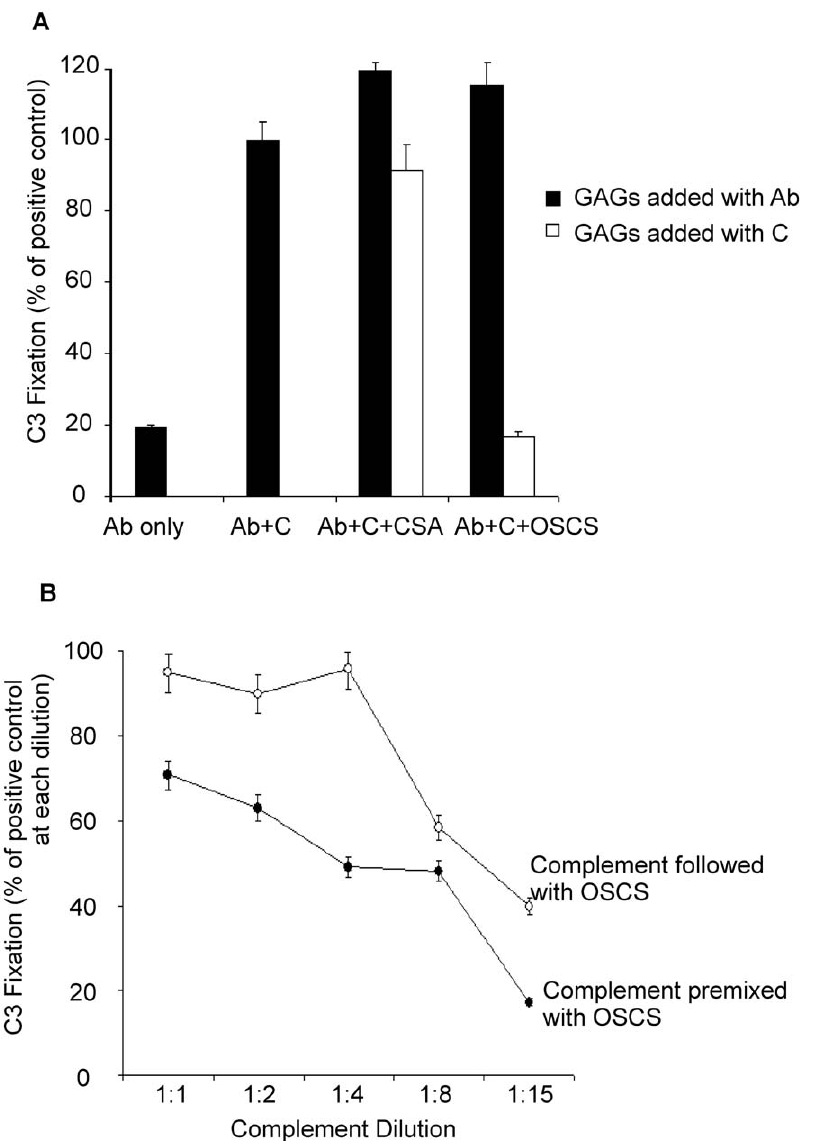
Figure 2. OSCS does not block the antigen/antibody interaction. (A) E. Coli BL21 bacteria were incubated with CSA or OSCS -treated monoclonal antibody 2E4, then washed and incubated with complement plasma ( & ); or antibody 2E4-treated E. Coli BL21 bacteria were incubated with CSA or OSCS-treated complement plasma ( % ). C3 fixation was determined by Anti-C3 binding using flow cytometry and expressed as a percentage of C3 fixation in the absence of GAGs (PBS positive control); (B) Different dilutions of complement plasma were added to 2E4-treated N E. Coli BL21 bacteria followed by the addition of 20 m g/ml of OSCS ( # ), or 2E4-treated bacteria were added to different dilutions of complement ). Complement C3 fixation was determined by anti-C3 monoclonal plasma that had been pre-mixed with 20 m g/ml of OSCS at 37 u C for 5 minutes ( antibody binding using flow cytometry. The percentage of C3 fixation was calculated as percentage of mean fluorescence intensity of samples without OSCS at a comparable complement plasma dilution. The abbreviation Ab indicates monoclonal antibody 2E4, C indicates